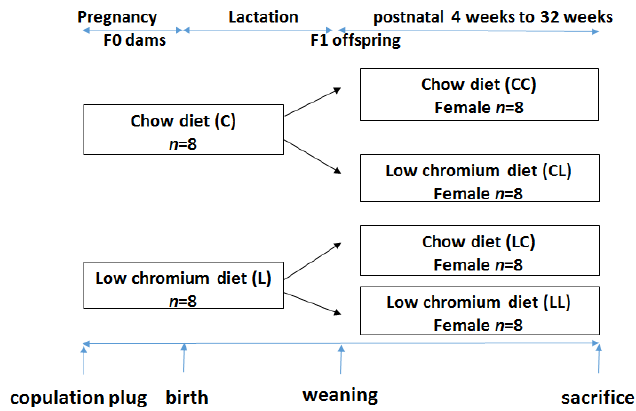
Figure 1. The timeline of the animal experiments.